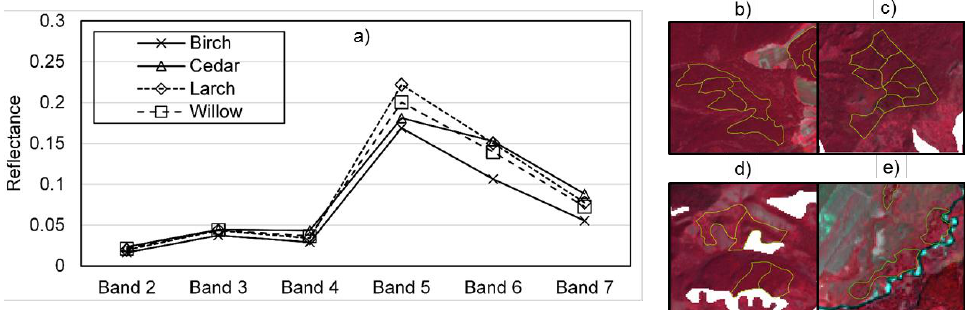
Figure 4. ( a ) Spectral data of tree species with cluster samples from the ground truth data of ( b ) birch, ( c ) cedar, ( d ) larch, and ( e ) willow. Table 2. Estimates of variable importance of the satellite imagery variables.